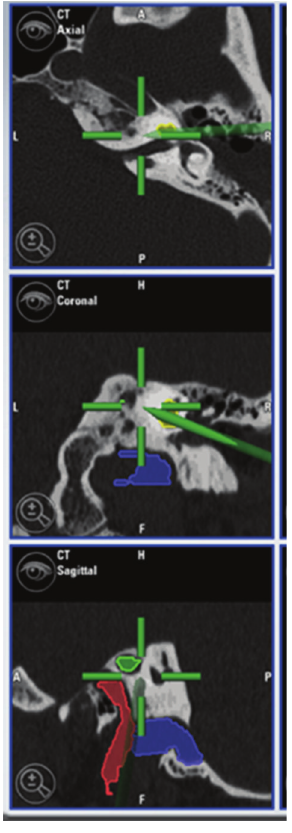
Figure 6: Intraoperative screenshot at the end of the drilling. The petrous apex lesion has been reached without damaging the surrounding structures ( blue : jugular bulb; yellow : cochlea; red : internal carotid artery; green : petrous apex